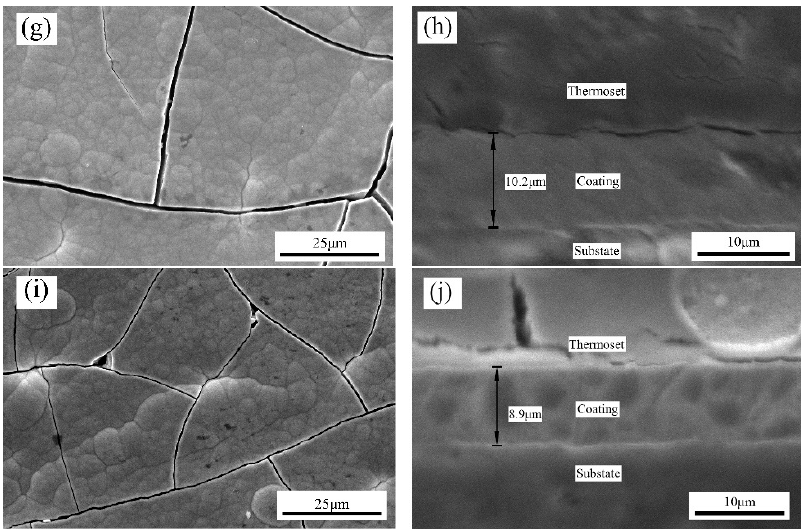
Figure 1. Surface and cross-sectional morphologies of coatings prepared with different sodium citrate concentrations: ( a , b ) 0, ( c , d ) 20, ( e , f ) 40, ( g , h ) 60, and ( i , j ) 80 g/L.